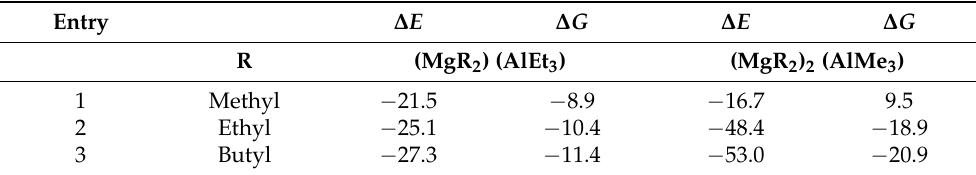
Table 5. Interaction energies and free energies ∆ E and ∆ G for the alkyl magnesium-aluminum complexes depicted in Figure 5.